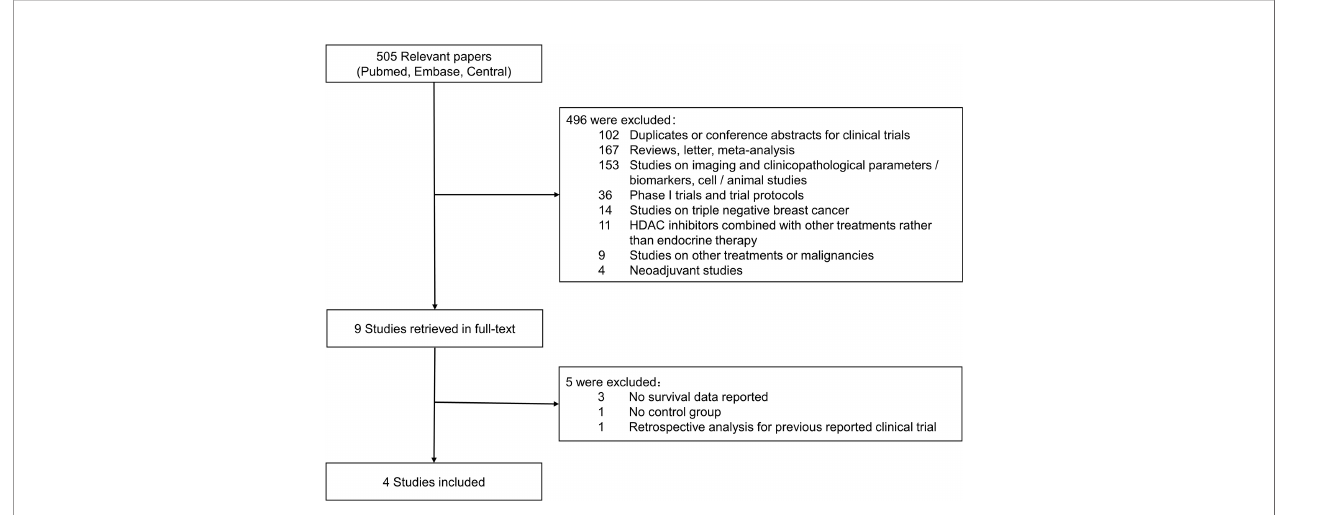
FIGURE 1 | Flowchart of articles reviewed and included in the